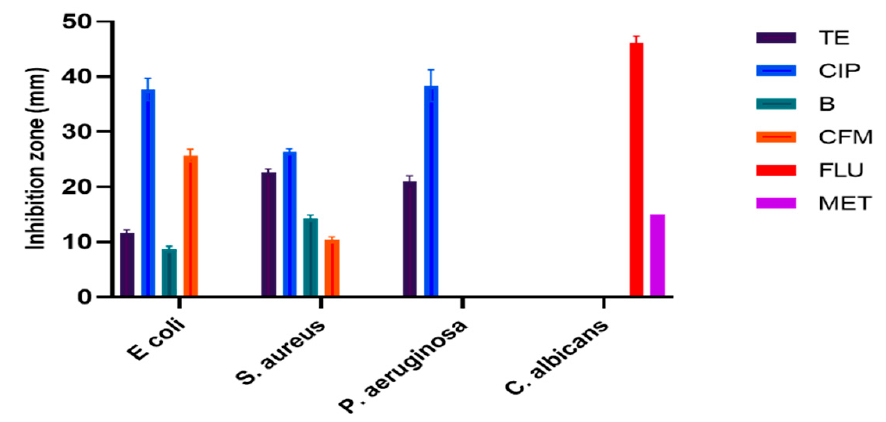
Figure 10. Activity of antibiotics against tested microbes.